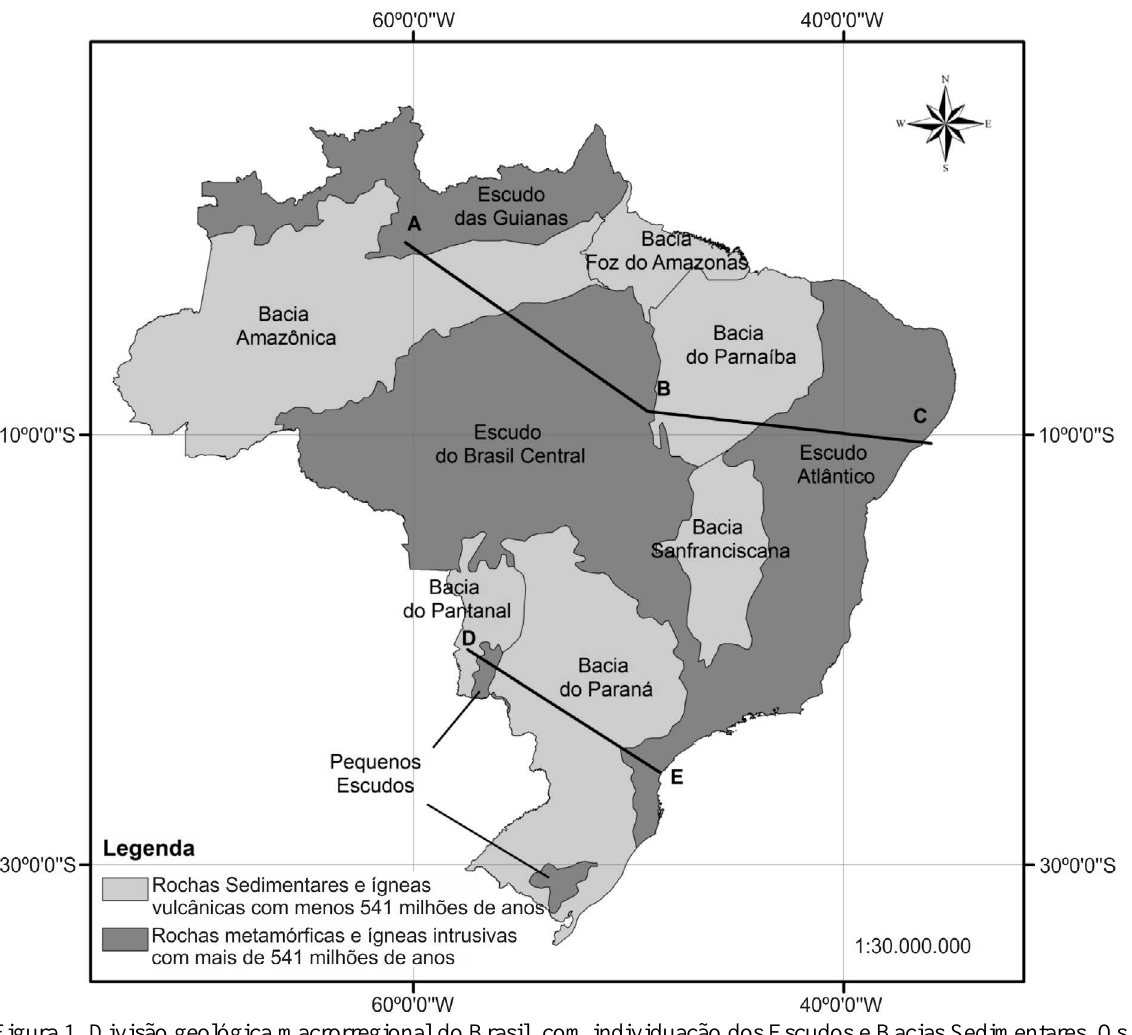
Figura 1. Divisão geológica macrorregional do Brasil, com individuação dos Escudos e Bacias Sedimentares. Os perfis A-B-C e D-E são vistos nas Figuras 2 e 3. Fonte principal: Zalán (2004). Figure 1. Geological macroregional framework of Brazil, separating Shields and Sedimentary Basins. The A-B- C and D-E profiles are exposed in the pictures 2 and 3. Main source: Zalán